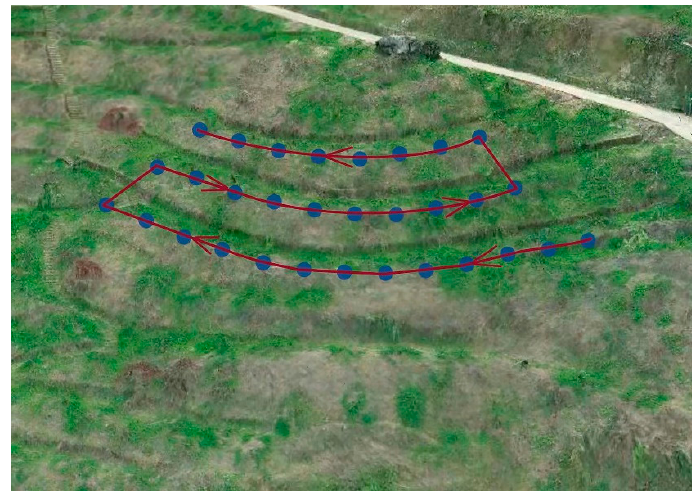
Figure 6. Z-shaped route diagram.